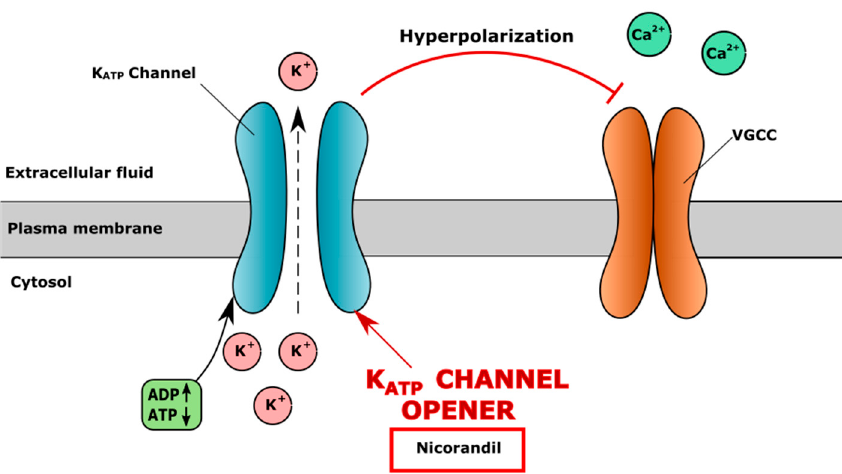
Figure 3. Mechanism of action of ATP-sensitive potassium (K ATP ) channel opener nicorandil. Nicorandil opens K ATP channel, causing extracellular efflux of K + , resulting in hyperpolarization of cell membrane and closure of voltage-gated calcium channel (VGCC), which results in decreased level of iCa 2+ .